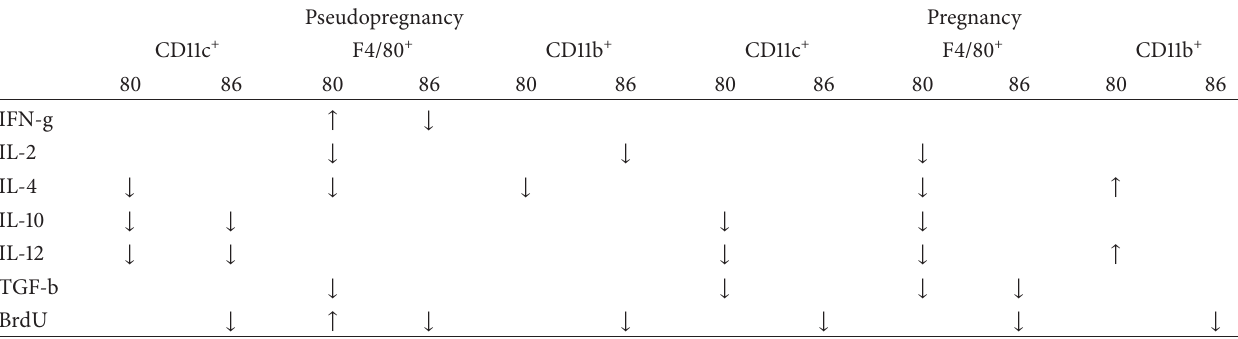
Table 1: Summary of influence of blockade of CD80 and CD86 costimulatory molecules on proliferation of OT-II CD4 + T lymphocytes and cytokine concentration in pseudopregnant and pregnant